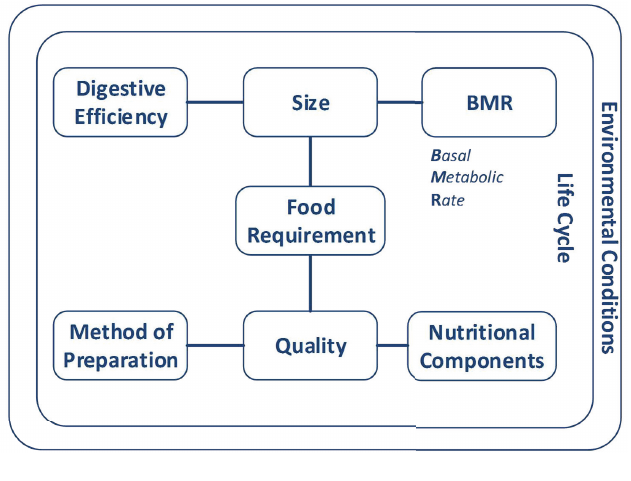
Fig. 2 Food Requirement Factors